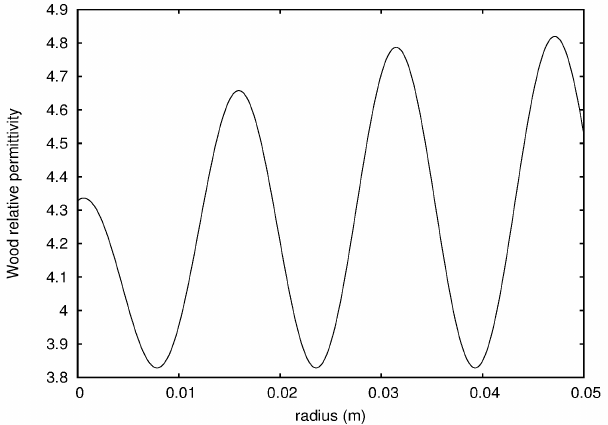
Figure 4. Relative permittivity function used for the calculation of the electric field in the exact model.